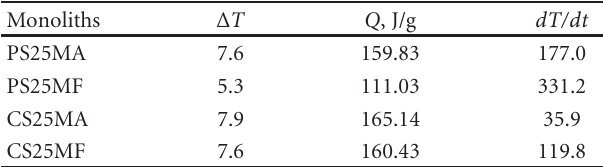
Table 3: Heat e ff ect and heat of wetting of